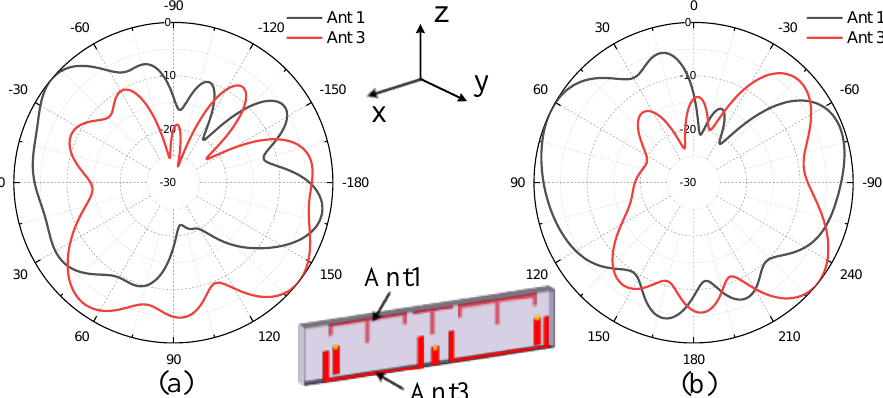
Figure 14. Measured radiation patterns of the proposed antenna at 3.5 GHz in ( a ) XOY plane and